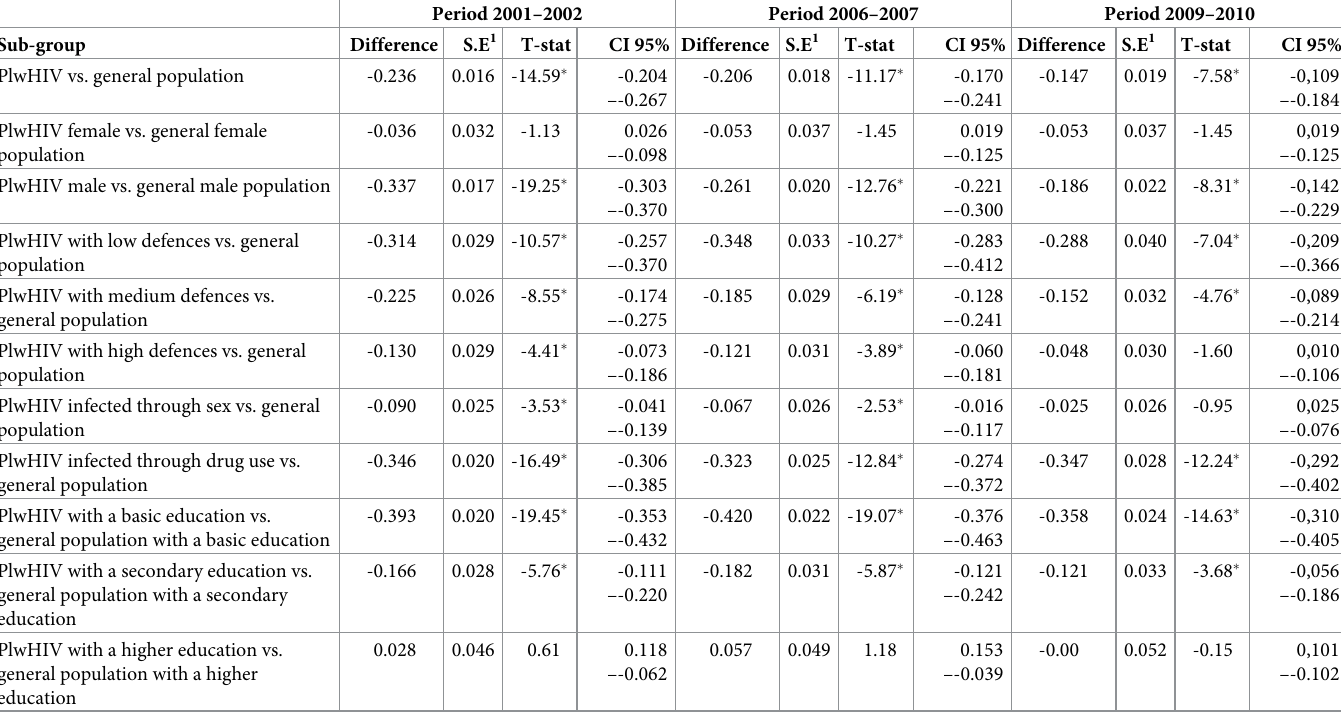
Table 3. Differences in employment rates between PlwHIV and general population. Results from Propensity Score Matching